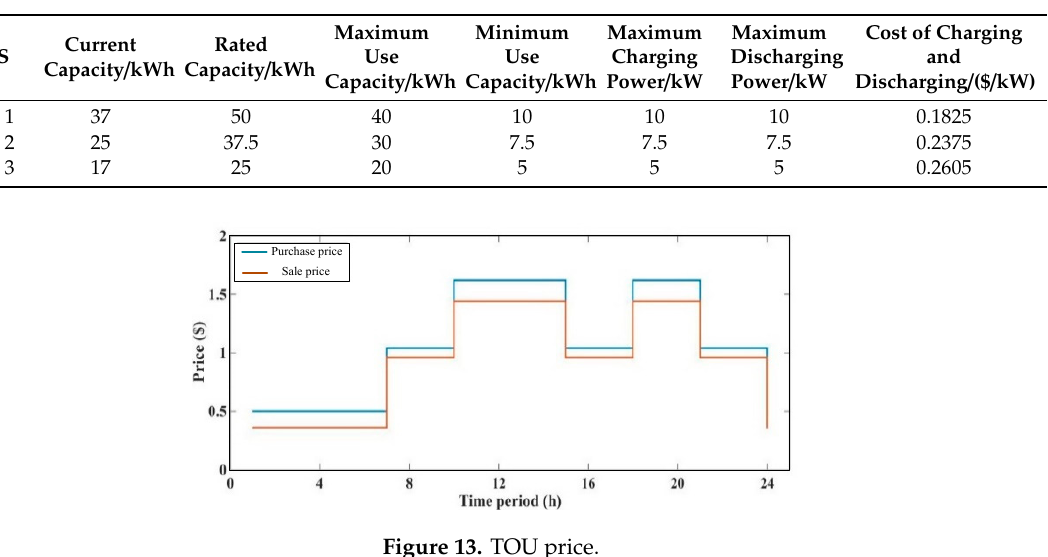
Figure 13. TOU price. Table 8. Parameters of multi-BESSs.